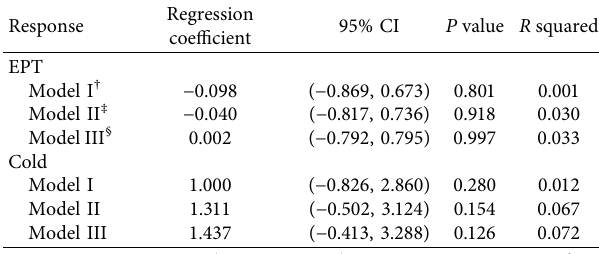
Table 2: Comparison of EPTand cold tests between well-controlled and uncontrolled diabetes groups based on a regression